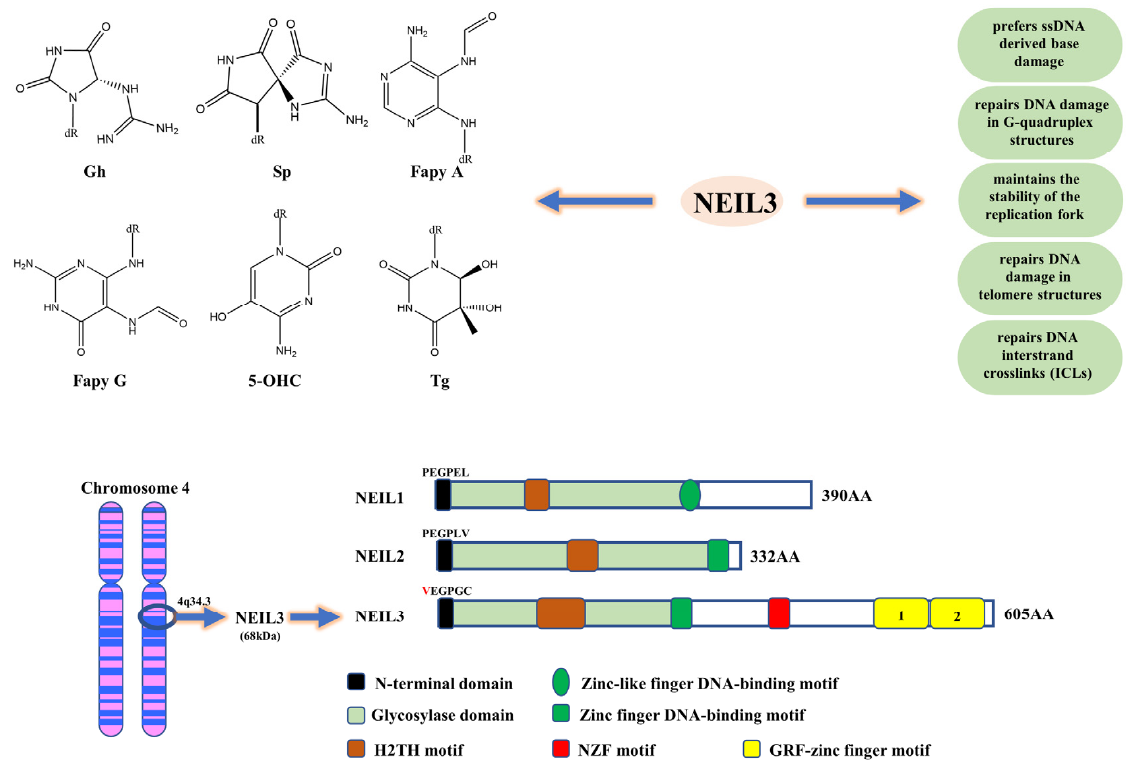
Figure 1. The structural and functional characteristics of NEIL3. Gh, Sp, FapyG, FapyA, 5-OHC and Tg are the main DNA base damage substrates of NEIL3. NEIL3 prefers base damage in ssDNA or G-quadruplex, maintains replication fork stability, and preferentially repairs telomeres and ICLs. The human NEIL3 gene is located on chromosome 4q34.3. The human NEIL3 protein is composed of an N-terminal domain, an H2TH motif, a zinc finger DNA-binding motif, a ZNF motif and a duplicated GRF-ZF motif. In the N-terminal domain of NEIL3, valine replaces the central catalytic role of proline.